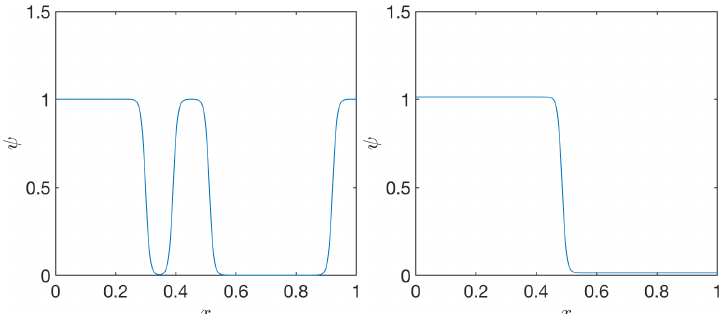
Figure A3. The solutions ψ ( x , t ) from Ex. A2 showing the impact of the coefficient θ . From left to right: θ = 1,10 with T ∞ = 4.5,5.5,